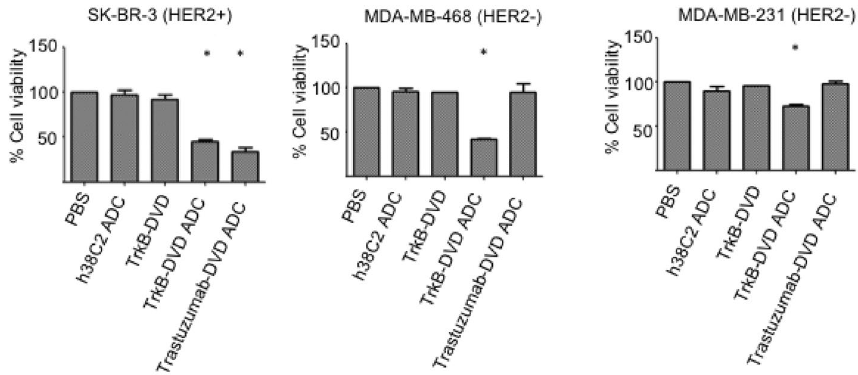
Figure 4. Effect of anti-TrkB DVD ADC on breast cancer cell lines. Cytotoxicity of anti-TrkB DVD- ADC following incubation with HER2+ breast cancer cell line SK-BR-3, and HER2− breast cancer cell lines MDA-MB-231 and MDA-MB-468 for 72 h at 37 °C. Unconjugated anti-TrkB DVD and MMAF- conjugated trastuzumab-based DVD-ADC and h38C2 IgG1-ADC served as controls. Breast cancer cell lines (5 × 10 3 cells/well) were seeded in 96-well plates and incubated with 100 nM of the various reagents. Cell viability was measured using the CellTiter 96 AQueous One Solution Cell Proliferation Assay kit following the manufacturer’s protocol. Vehicle-treated cells were set to 100% viability. All experiments were performed in triplicate, error bars indicate standard deviation. A t test was used to compare the treatment groups. All statistical evaluations of data were performed using GraphPad Prism 8 software. Statistical significance was achieved at a p value ≤ 0.05. (*, p ≤